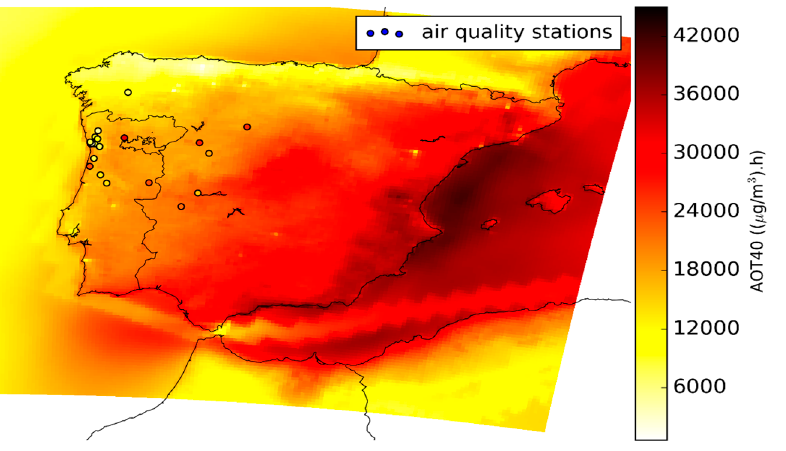
Figure 7. AOT40 levels ( µ g · m − 3 · h) averaged for the 3 simulation years and over Iberian Peninsula (D03, 9 × 9 km 2 horizontal resolution). The circles represent the AOT40 levels measured by the air quality monitoring stations.